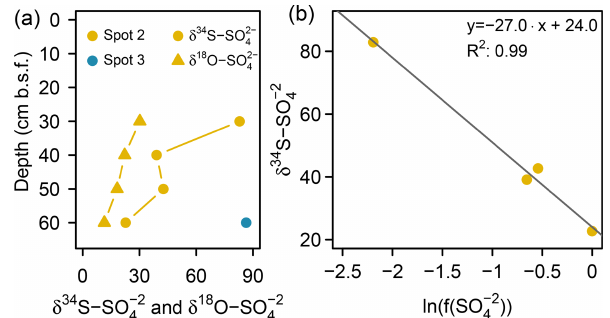
Figure 6. (a) S and O isotope composition of sulfate. Sufficient SO 2 − for δ 34 S and δ 18 O ratio analysis was only available at the 4 bottom of spot 2 and spot 3 (here only δ 34 S). (b) Rayleigh plot for measured SO 2 − depletion at spot 4